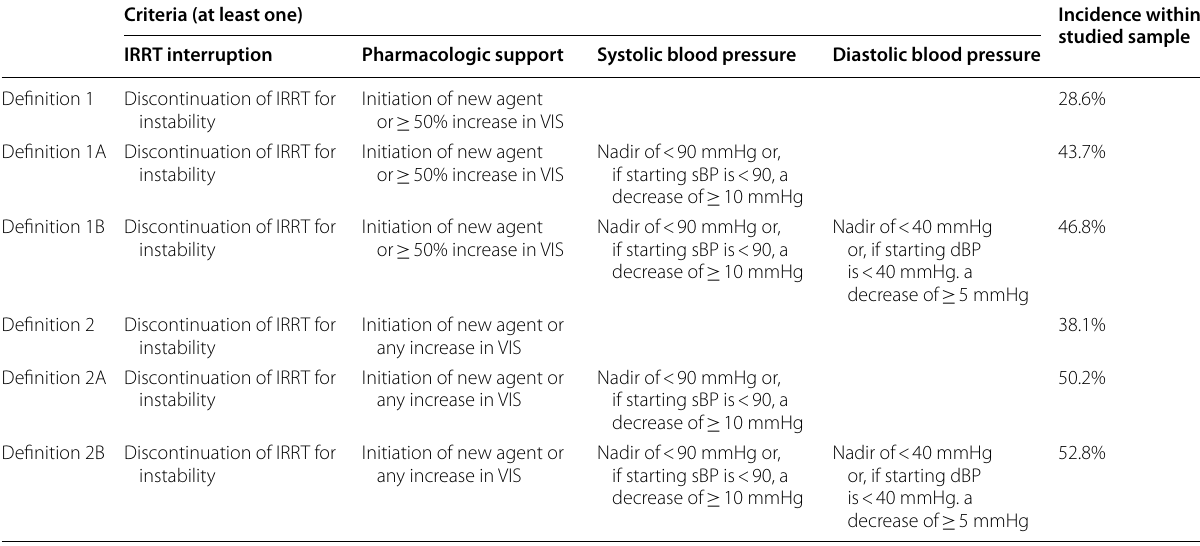
dBP diastolic arterial blood pressure, sBP systolic arterial blood pressure, VIS vasoactive‑inotropic score